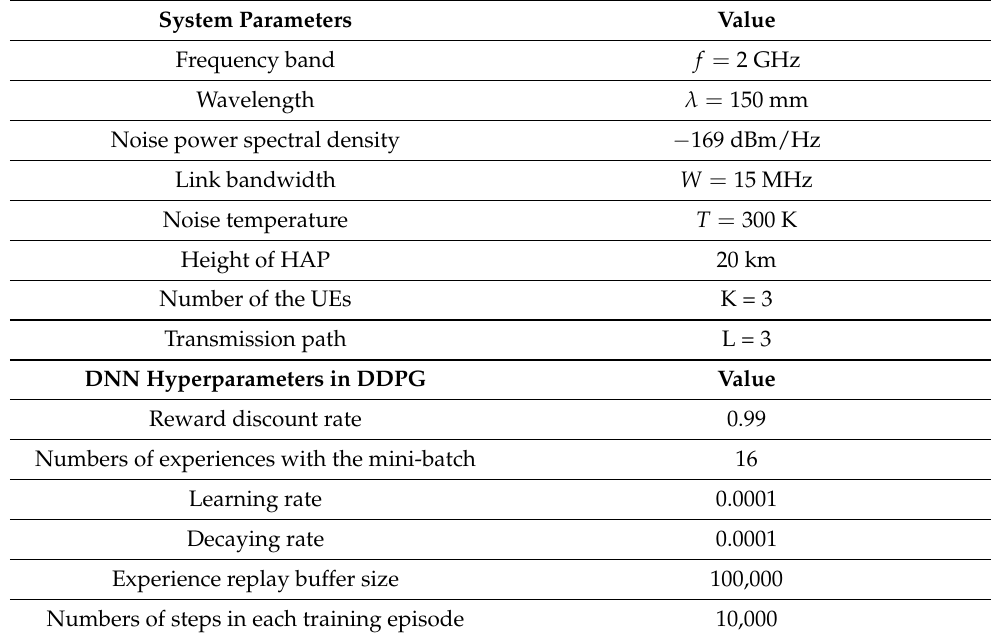
Table 1. System and DNN